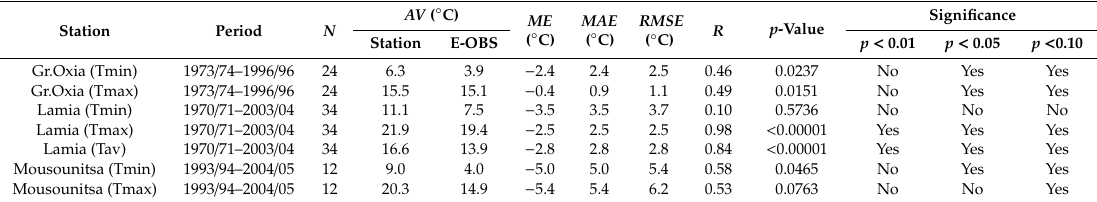
Table 6. Statistical characteristics and e ffi cient criteria of annual observed air temperature measurements and E-OBS dataset.